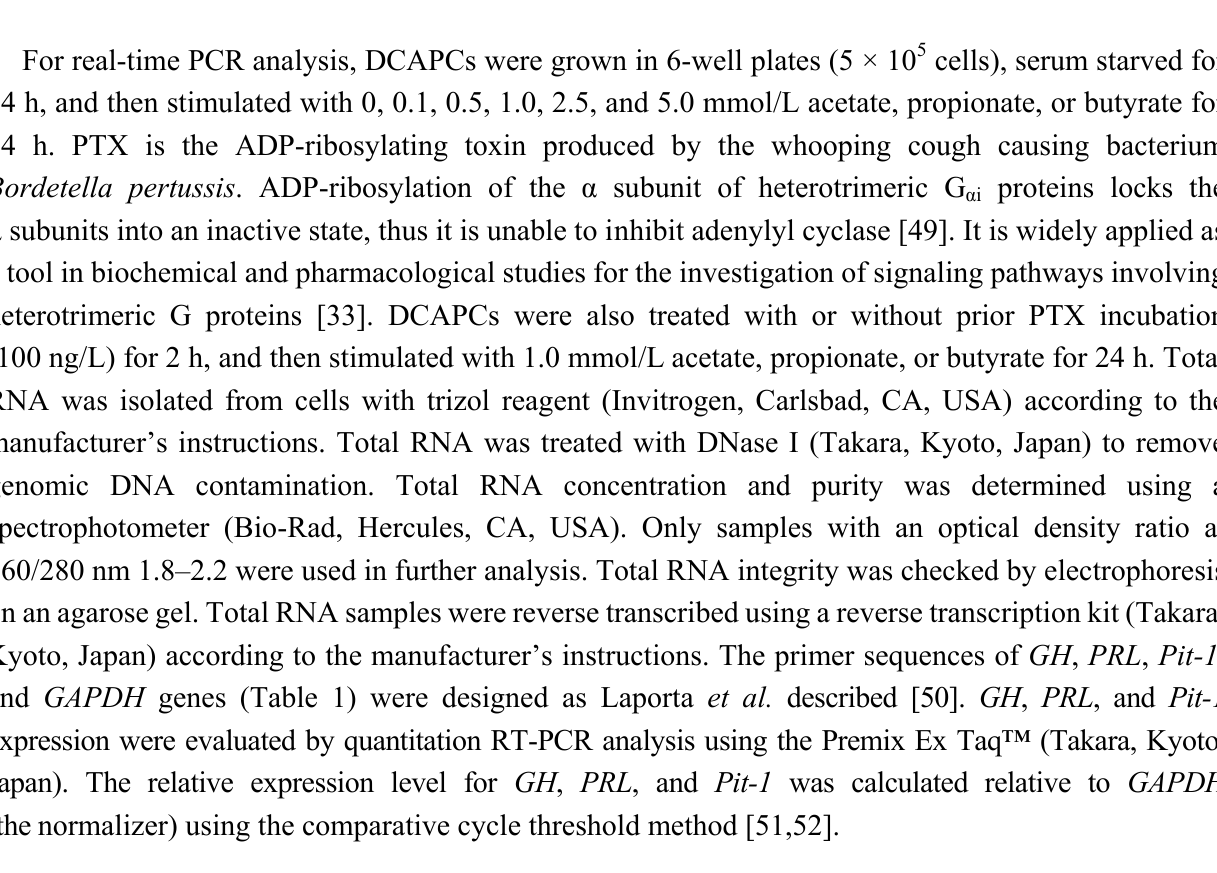
Table 1. The primer sequences of bovine GAPDH , GH , PRL , and Pit-1